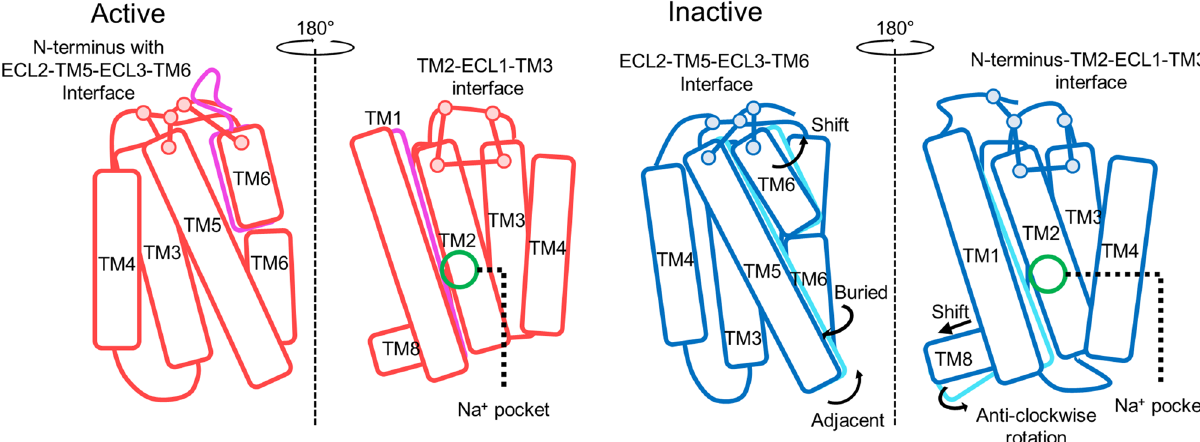
Figure 8. Schematic figure of dynamical changes and inter-helical interaction changes after the toggle switch mutation in CB1. The active and inactive of wildtype CB1 structures are colored as red and blue and of mutant CB1 are magenta and cyan, respectively. Pairwise interactions are presented as solid lines, which are decreased after the mutation. Especially, the position of Na + pocket is marked as green